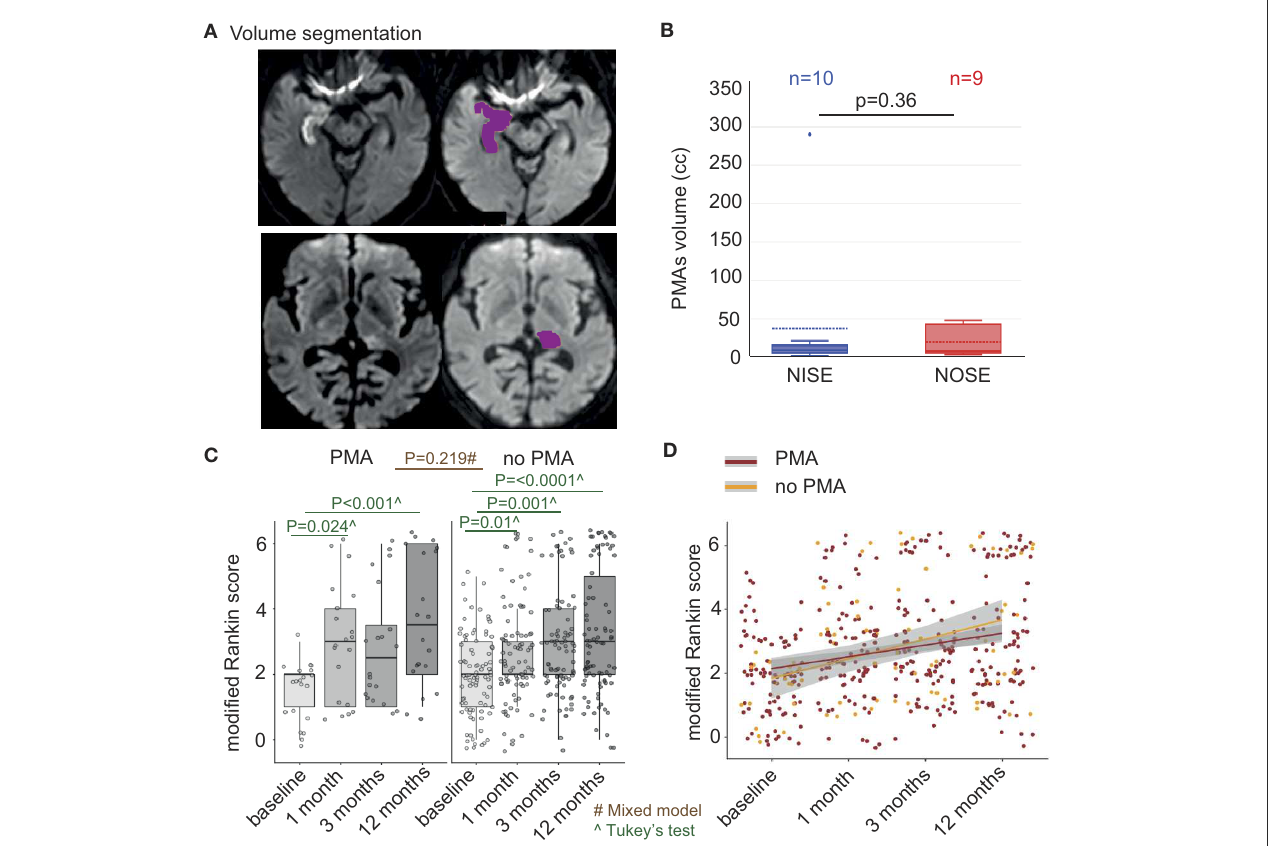
FIGURE5 PMA volumes are similar in NOSE and NISE patients and PMA is related to prognosis. (A) PMA volumetry in DWI sequences. Semi-automatic quantification in one-shot analysis by OLEA (PMA is circumscribed in purple; colors were changed for purposes concerning the figure). Right mesial temporal hypersignal including the hippocampus (upper panel) and left posterior thalamic hypersignal (bottom panel). (B) Mean PMA volumes in each group. The two groups had a similar PMA volume ( p = 0.36); note that there was an outlier in the NISE group with a much higher volume than the others at 290ml, with a hypersignal in DWI of the majority of the left hemisphere cortex, the thalamus and at 7 days a right cerebellar diaschisis of partial NCSE secondarily generalized in a 52-year-old man institutionalized for encephalopathy evolving since childhood. (C) Individual mRS in patients with PMA and those without PMA. Patients with PMA had an average mRS of 1.5 at baseline, 3.1 at 1 month, 2.8 at 3 months, and 3.6 at 12 months. Patients without PMA had an average mRS of 1.5 at baseline, 2.2 at 1 month, 2.8 at 3 months, and 2.7 at 12 months. (D) Correlations between PMA evolution and outcome (mRS) at different time points (Pearson correlations, r = 0.376 in the PMA group, r = 0.252 in the non-PMA group). Alpha = 0.05/3 = 0.017.